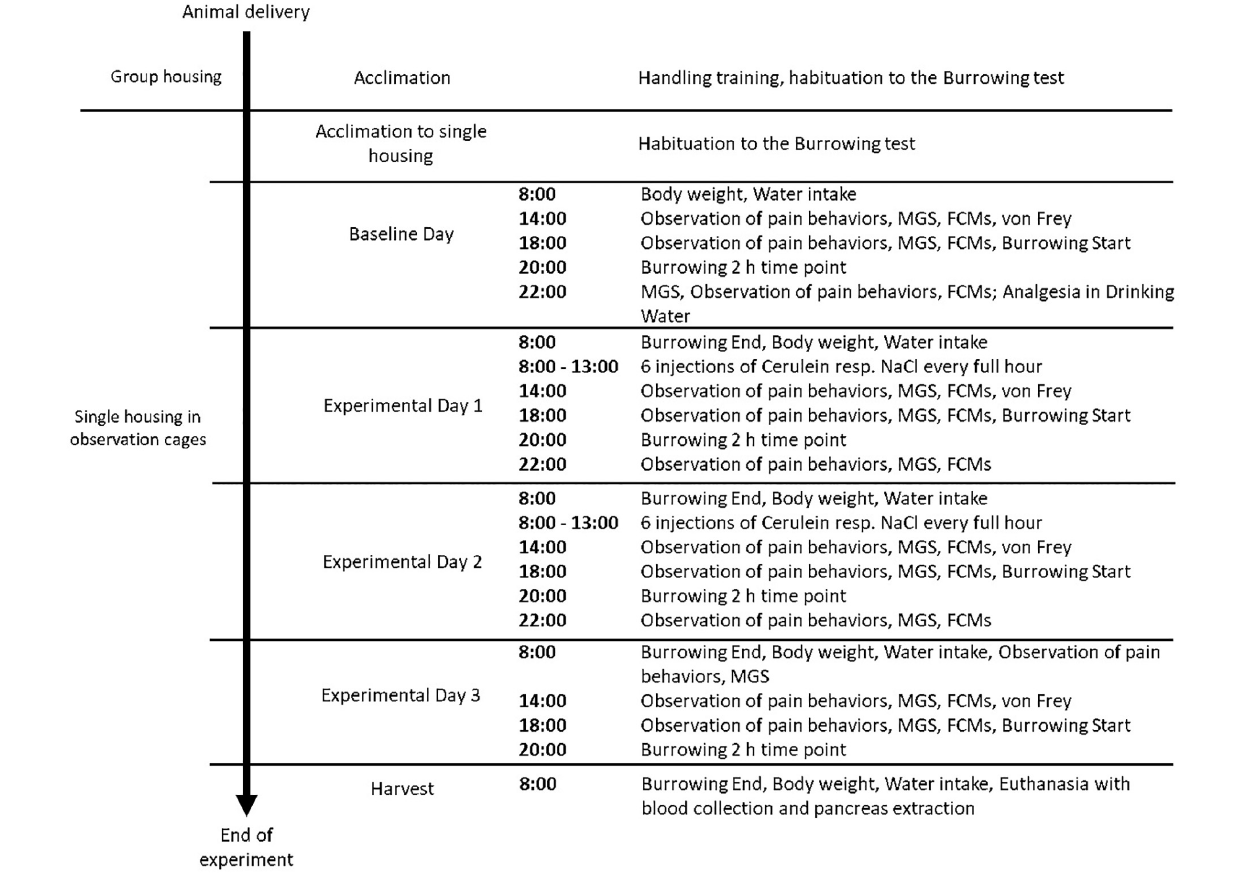
FIGURE 1 | Experimental Schedule of procedures performed in each treatment group. Animals were assigned randomly to a treatment group ( n = 18, NaCl, Cer, Cer + Bup, Cer + PT, Cer + Met). Each parameter was assessed at baseline level in naïve mice, followed by measurements conducted on Experimental Days 1–3 and the day of harvest. MGS = Mouse Grimace Scale, FCMs = Fecal Corticosterone